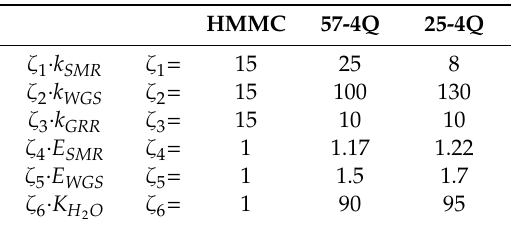
Table 3. Values of the adjusting dimensionless coe ffi cients ζ 1 – ζ 6 , adopted to adapt the Xu and Froment kinetic model (Table 2) to the catalysts investigated in this